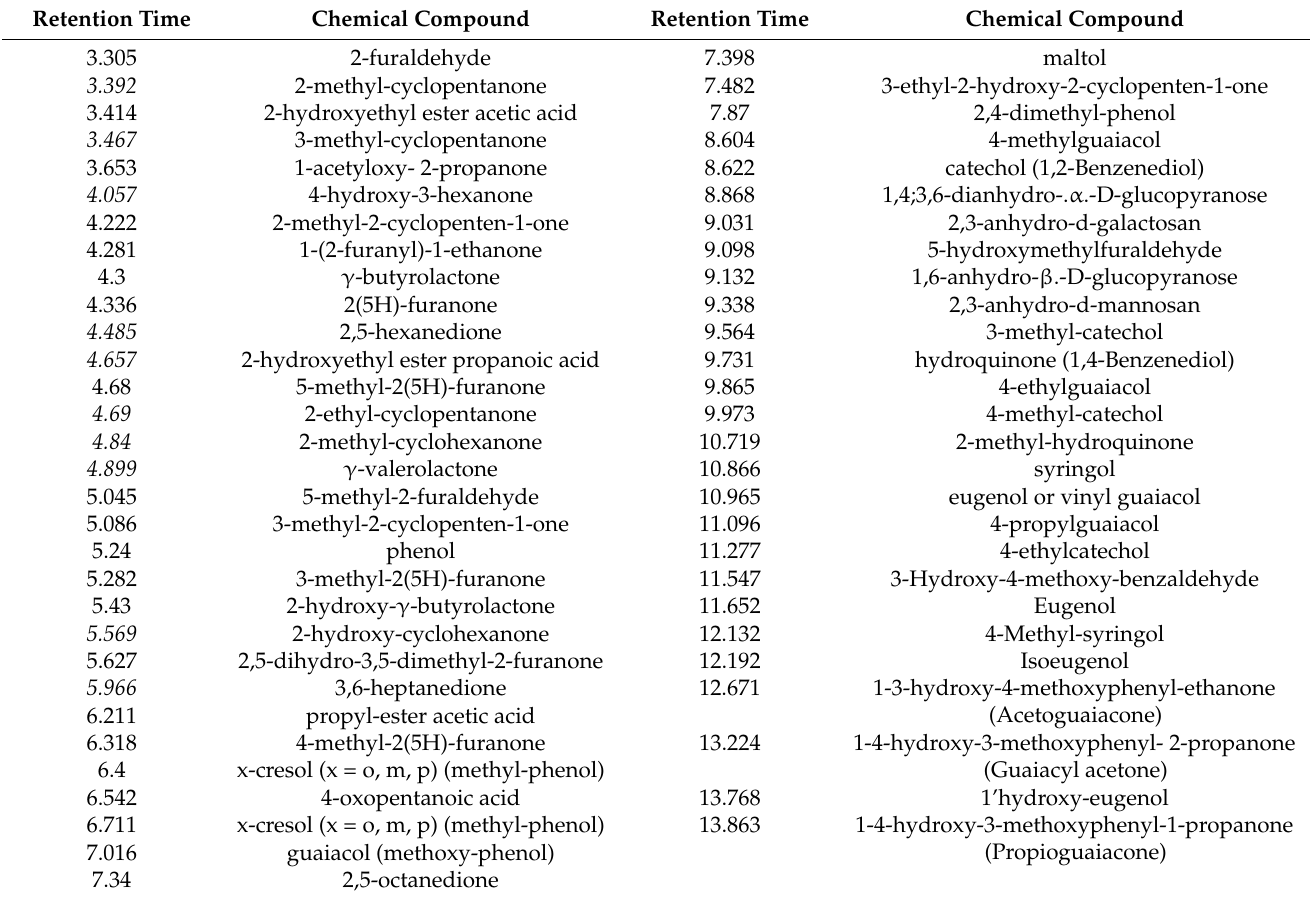
Table 3. Main compounds identified over GC-MS and their respective retention